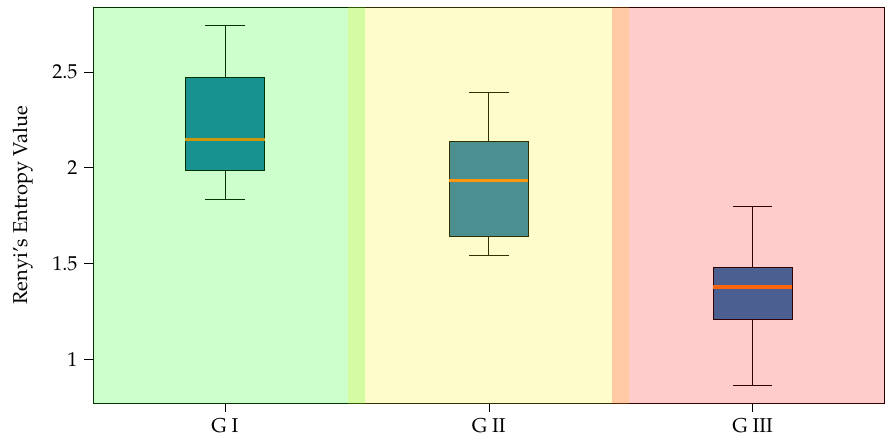
Figure 8. Rényi’s entropy-based retained information within the estimated functional connectivity matrices using KSC-FCnet. The background codes the group membership (best, medium, and worst performance clusters). Boxplot representation is used to present the retained information within each